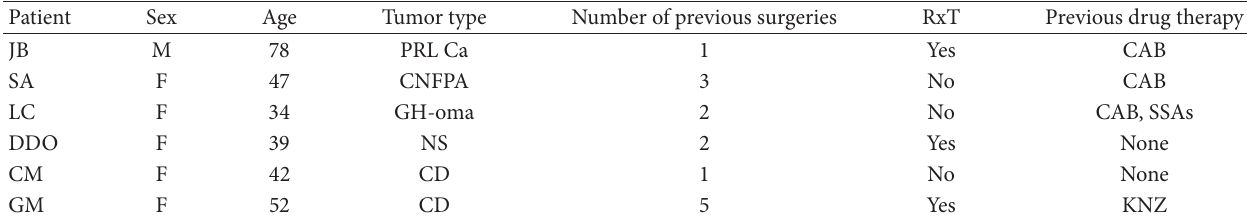
Table 1: Main clinical traits of 6 patients with intention-to-treat with temozolomide.